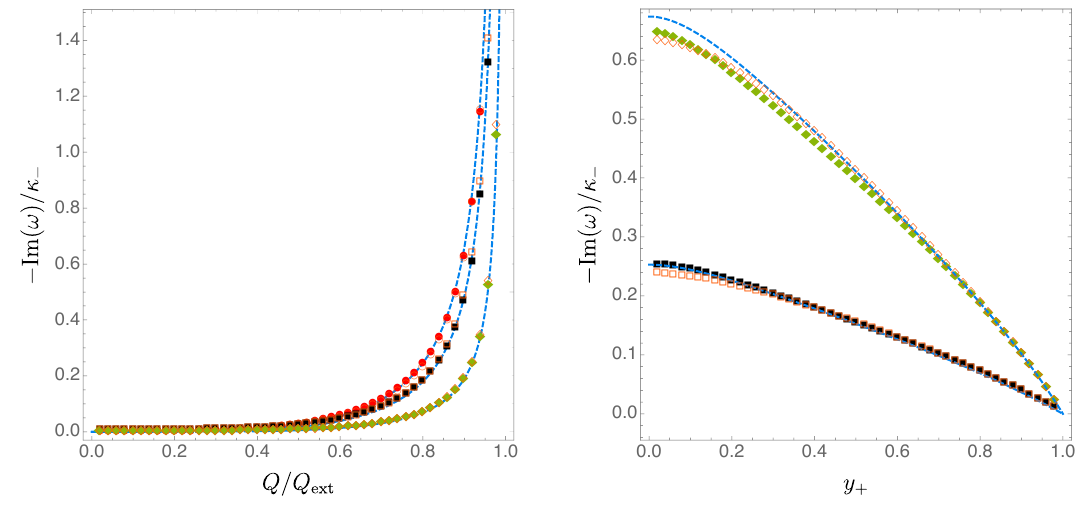
Figure 3 . Photon sphere modes for modes (cid:8) + with ‘ = 1 ((cid:12)lled marks: disks, squares, diamonds) and (cid:8) (cid:0) with ‘ = 2 (empty orange marks: circles, squares, diamonds). The dashed blue curves are the WKB predictions. Left panel: the three curves are for y + = 0 : 1 (top), y + = 0 : 4 (middle) and y + = 0 : 8 (bottom). Note that the empty marks here are the (cid:12)lled marks in (cid:12)gure 2. Right panel: the black (cid:12)lled/empty squares describe solutions with Q=Q ext = 0 : 7992, while the green (cid:12)lled/empty diamonds represent the numerical results for Q=Q ext = 0 : 8991. n = 0) and (cid:8) modes with ‘ = 2 (and n = 0). We see that (cid:8) modes with ‘ = 1 typically (cid:0) + have lower (cid:0) Im( ! ) =(cid:20) (for (cid:12)xed background parameters) than (cid:8) modes with ‘ = 2. (cid:0) (cid:0) However, there are small islands in the parameter space where the opposite occurs: see . 0 : 9. A similar conclusion is reached from curve y = 0 : 1 (red disks/circles) for Q=Q + ext the right panel of (cid:12)gure 3. Here we plot the same modes but this time for RNdS with (cid:12)xed Q and varying y . We see that typically the (cid:8) , ‘ = 1 modes dominate over the (cid:8) , ‘ = + + (cid:0)